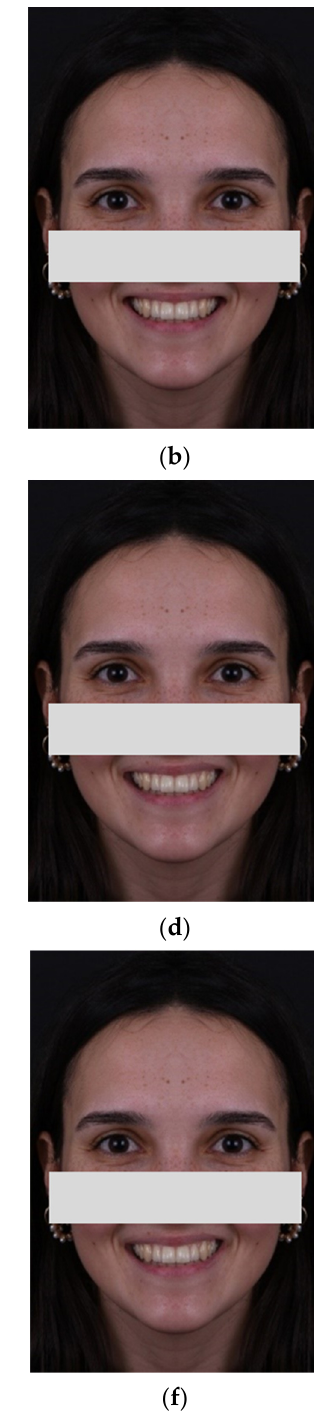
Figure 1. ( a ) Original asymmetric image; ( b ) Symmetrical image—Control; ( c ) 3-degree CL tilt; ( d ) OP parallel to the IL; ( e ) OP parallel to the CL; ( f ) OP mean between the IL and the CL equivalent to 1.5 degrees.